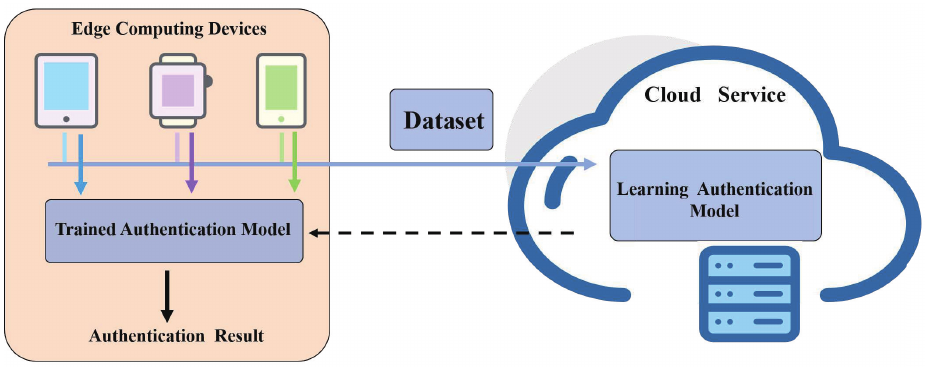
Figure 1. The framework of authentication.